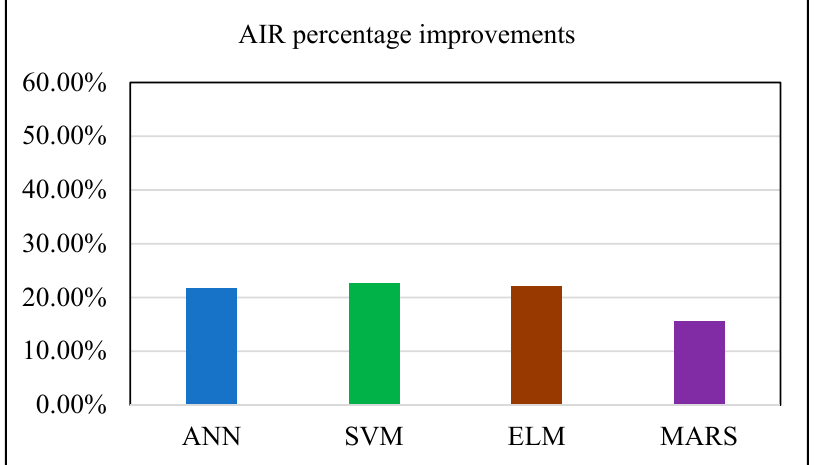
Figure 4. Accurate identification rate (AIR) percentage improvements for an multiple-input multiple-output (MIMO) process with two outputs, using the second scheme instead of the first scheme.